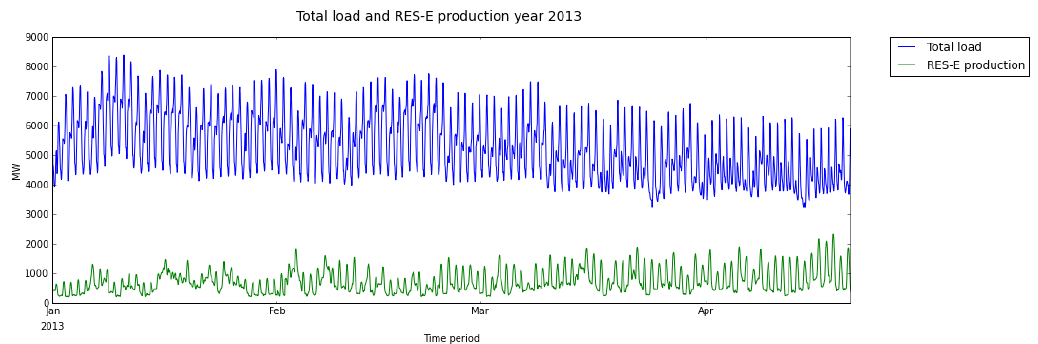
Figure 1. Demand and RES ‐ E production for the year 2013: Plotting the time series electricity demand in the Greek electricity market for the year 2013 along with the respective RES ‐ E production for the same year gives a clear perspective on how their relationship affects the residual load’s levels and profiles in Greece. Both demand and production ( y -axis) are in megawatts while time ( x -axis) is in months.